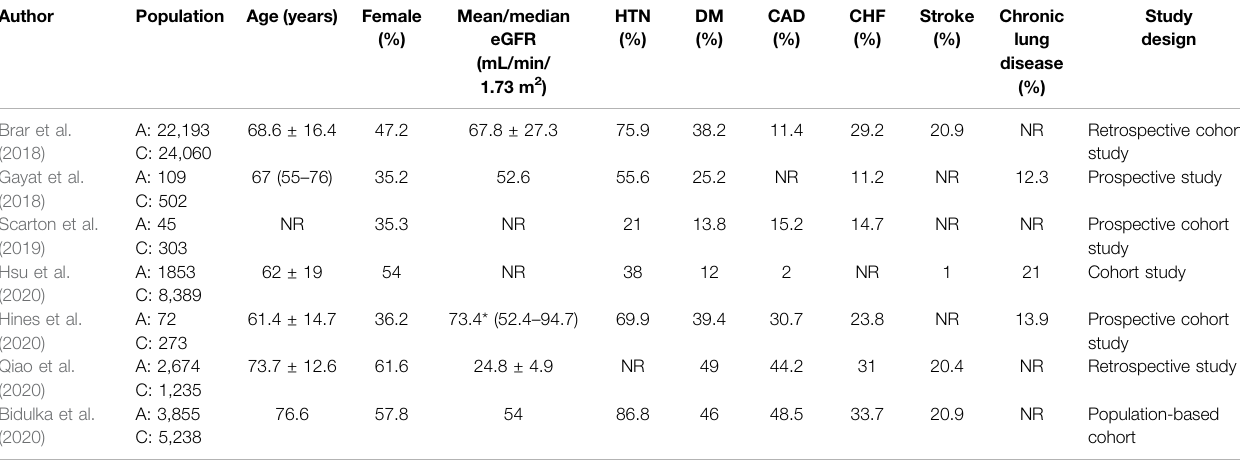
TABLE 1 | Baseline characteristics of included